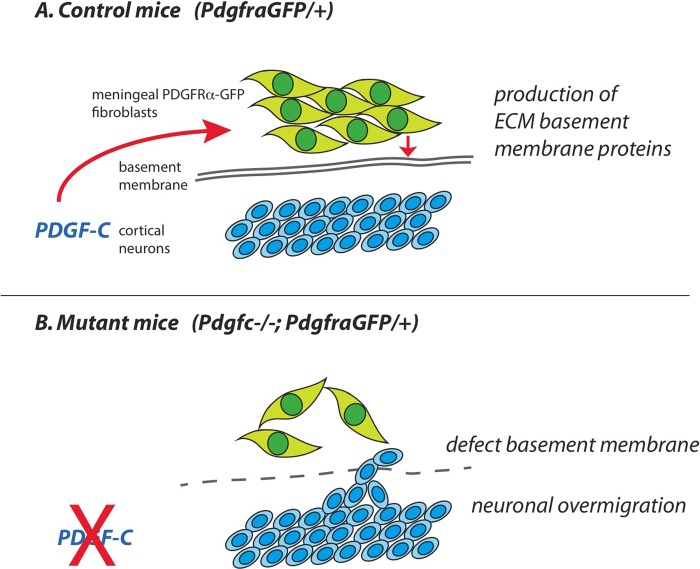
Suggested model. (A) Based on data in this paper we suggest that PDGF-C expressed by neurons in the cerebral cortex is needed for proper organization of PDGFRα-positive meningeal fibroblasts, production of extracellular matrix proteins (ECM) and formation of the glial basement membrane. (B) Without PDGF-C, the arrangement of meningeal cells and ECM is irregular, no proper basement membrane is formed and cortical neurons can migrated out of the brain.